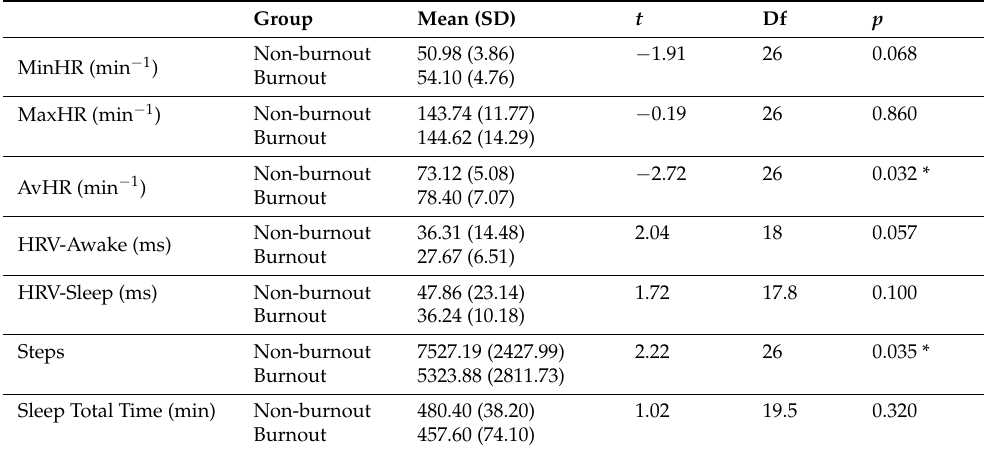
Table 2. Results of Firstbeat ® recordings with group means, standard deviations, and t -test results ( p < 0.05